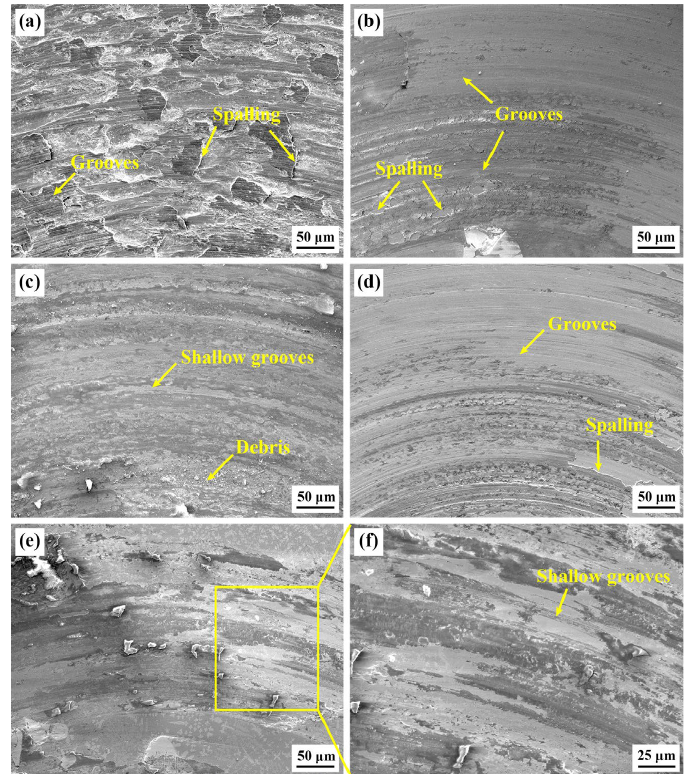
Figure 14. SEM wear morphologies of the Stellite 6/WC composite coatings of different specimens: ( a ) substrate; ( b ) S1; ( c ) S2; ( d ) S3; ( e ) S4; ( f ) magnification of the yellow rectangular area.